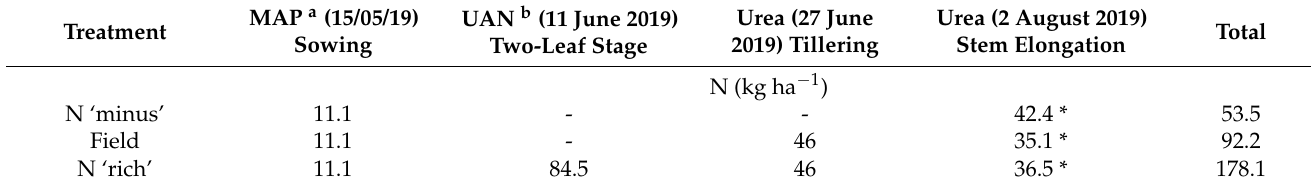
Figure 1. Strip design and sampling points overlayed with soil zones in a 64-ha on-farm experiment in Tarlee-SA, 2019. Table 1. Fertiliser applied to N-rich and N-minus strips and the field area.